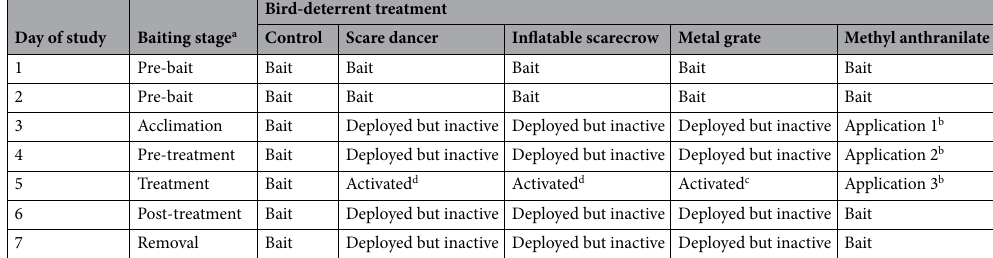
wind rows, near water sources, or along shelter belts; and based on distance to nearby sites (i.e., goal of > 500 m to nearest site). We cleared sites of tall grass and debris to ease discovery and access to the bird seed by smaller birds. We visited sites every 2–3 days to replenish and maintain ~ 2 kg of bait at the sites. We pre-baited sites for ~ 4 weeks to ensure birds were well-acclimated to visiting sites daily. We monitored visitation to sites using remote cameras (RECONYX PC900, RECONYX Inc, Holmen, WI, USA) mounted on T-post approximately 5 m from the bait pile, 1.5 m above ground, and angled down at 70° to provide a consistent field of view at each site. Cameras were programmed to record time-lapse imagery every 2 min (i.e., 720 images/day) which was used to calculate indices of species visitation. We used the Colorado Parks and Wildlife Photo Database to process all time-lapse imagery (Ivan and Newkirk 2016). For each image, a single observer recorded presence and count of each unique species present. We selected the best 20 sites (Fig. 1) based on the greatest rates of bird visitation, greatest diversity of bird species visiting, and lowest presence of other species that consumed large quantities of the bird seed (e.g., raccoons, deer, skunks). For the trial, we randomly assigned a deterrent treatment (i.e., inflatable scarecrow, metal grate, methyl anthranilate) or control (i.e., no deterrent method) to five sites each. We re-used the control sites to test the scare dancer after testing the initial four treatments, because the scare dancers were received later than first three treatments. We visited bait sites daily and weighed the amount of bird seed remaining to calculate the amount consumed with digital scales (MeasureTek GGS_42964, MeasureTek Scale Co, Ltd, Vancouver, BC, Canada). We replenished each site to ensure ~ 2 kg of fresh bird seed was available each day. The trials were seven consecutive days (Table 1). We focused on species visitation from 1 h before first light (~ 0500 h) to midday (1200 h) each day, because this time period represented the critical hours in which hazards occurred at toxic bait sites 22,24 . We visited the bait sites between 1200 and 1400 h each day to replenish bait and prepare sites for the following day. The 7-day trial consisted of: